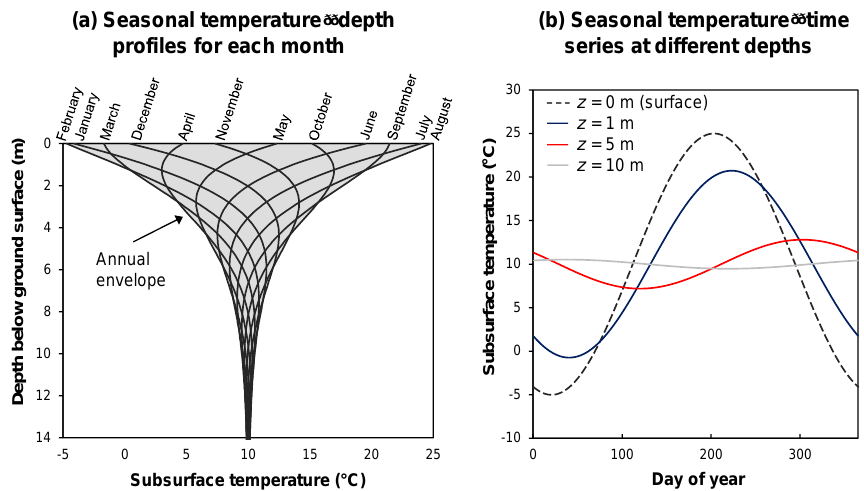
Figure 5. (a) Temperature–depth profiles for each month obtained from Stallman’s equation (Eqs. 5–7) for homogeneous soil subject to harmonic seasonal surface-temperature variation. (b) Temperature–time series generated with Stallman’s equation for depths of 0, 1, 5, and 10m. In (a) and (b) , the thermal properties for sand at 50% saturation (Table 2) were employed, and a recharge Darcy velocity of 0.2myr − 1 was assumed. The boundary condition parameters T m , A , ϕ , and p were assigned values of 10 ◦ C, 15 ◦ C, − 4.355 radians, and 31536000s (1 year), respectively, to represent typical surface-temperature conditions for a forested site in New Brunswick, Canada (e.g., Kurylyk et al.,